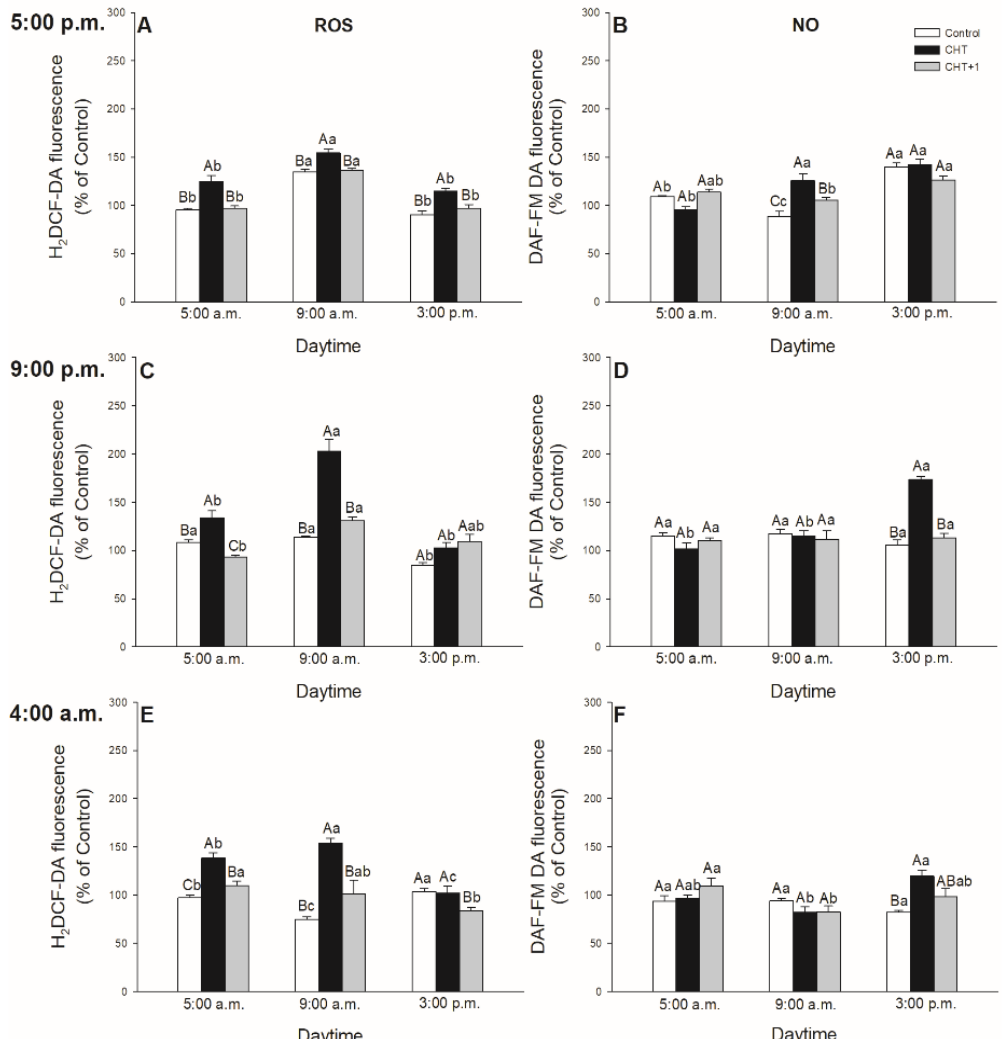
Figure 3. Changes in the production of ROS ( A , C , E ) and NO ( B , D , F ) in stomata on the abaxial epidermal strips of intact tomato plants treated foliar with 100 μg mL -1 chitosan (CHT) dissolved in the experimental buffer (1 mM AA, 10 mM MES/TRIS, 10 mM KCl, 0.1 mM CaCl 2 , pH 6.15) at different daytimes: at the end of light cycle (17:00 hrs; (A)), at night (21:00 hrs; (B)), at dawn (04:00 hrs; (C)). Measurements were disposed at constant times after treatments (5:00 a.m., 9:00 a.m. and 3:00 p.m.). Means ± SE, n = 3. Means were analyzed by two-way ANOVA, significant differences among the data were analyzed by Holm–Sidak test. Mean values significantly different at P < 0.05 were signed with different letters, upper case letters indicate the effects of the treatment at the same daytime, and lower case letters indicate the effects of the daytime under the same treatment. (Control: treatment with 1 mM Acetic acid buffer (AA); CHT: treatment with 100 μg mL -1 chitosan in experimental buffer containing AA; CHT+1: untreated distal leaf level from the CHT-treated one).